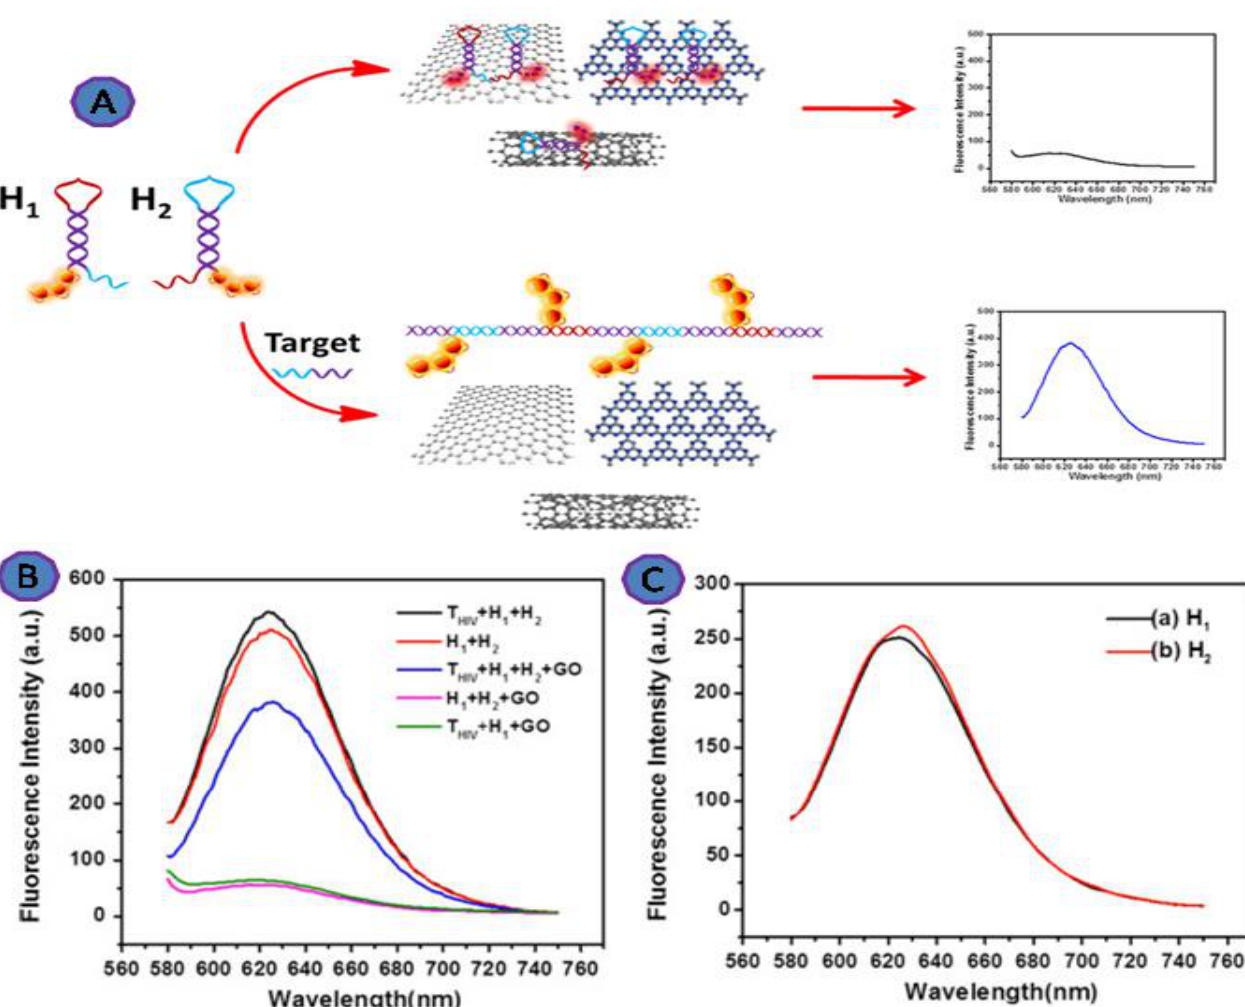
Figure 8. ( A ) Scheme showing graphene oxide (GO)-based HCR for DNA detection and the fluorescence response of the system under different conditions; ( B ) THIV + H1 + H2; H1 + H2; THIV + H1 + H2 + GO; H1 + H2 + GO; THIV + H1 + GO; ( C ) H1; H2. [H1] = 100 nM, [H2] = 100 nM, [THIV] = 100 nM. Reprinted with permission from Ref. [73]. Copyright 2017, Elsevier. Moreover, Zhang et al. developed a fluorescence biosensing technique to detect HIV-1 protease based on GO, using covalently bonded, fluorescently labeled HIV-1 protease target peptide molecules with GO. The fluorescence was increased upon the addition of HIV-1 protease as a result of the peptide cleavage and the release of the fluorescent peptide fragment away from the GO, as shown in Figure 9. This fluorescence-based detection assay was successfully detected as little as 18 ng/mL of HIV-1 protease